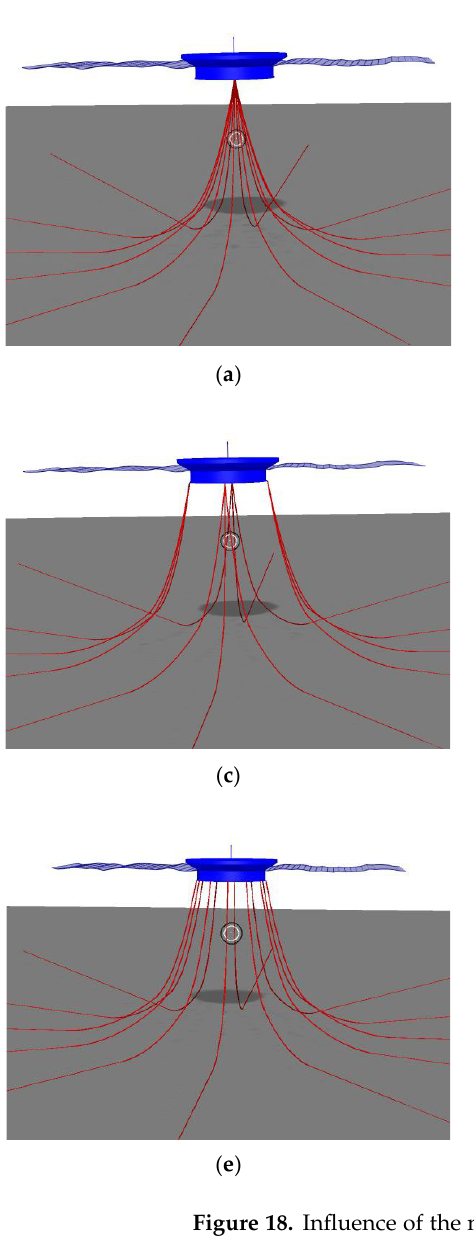
Figure 18. Influence of the number of connection points on the mooring system. ( a ) The coupled system for analysis with one connection point; ( b ) schematic diagram of the design of one connection point; ( c ) the coupled system for analysis with four connection points; ( d ) schematic diagram of the design of four connection points; ( e ) the coupled system for analysis with twelve connection points; ( f ) schematic diagram of the design of twelve connection